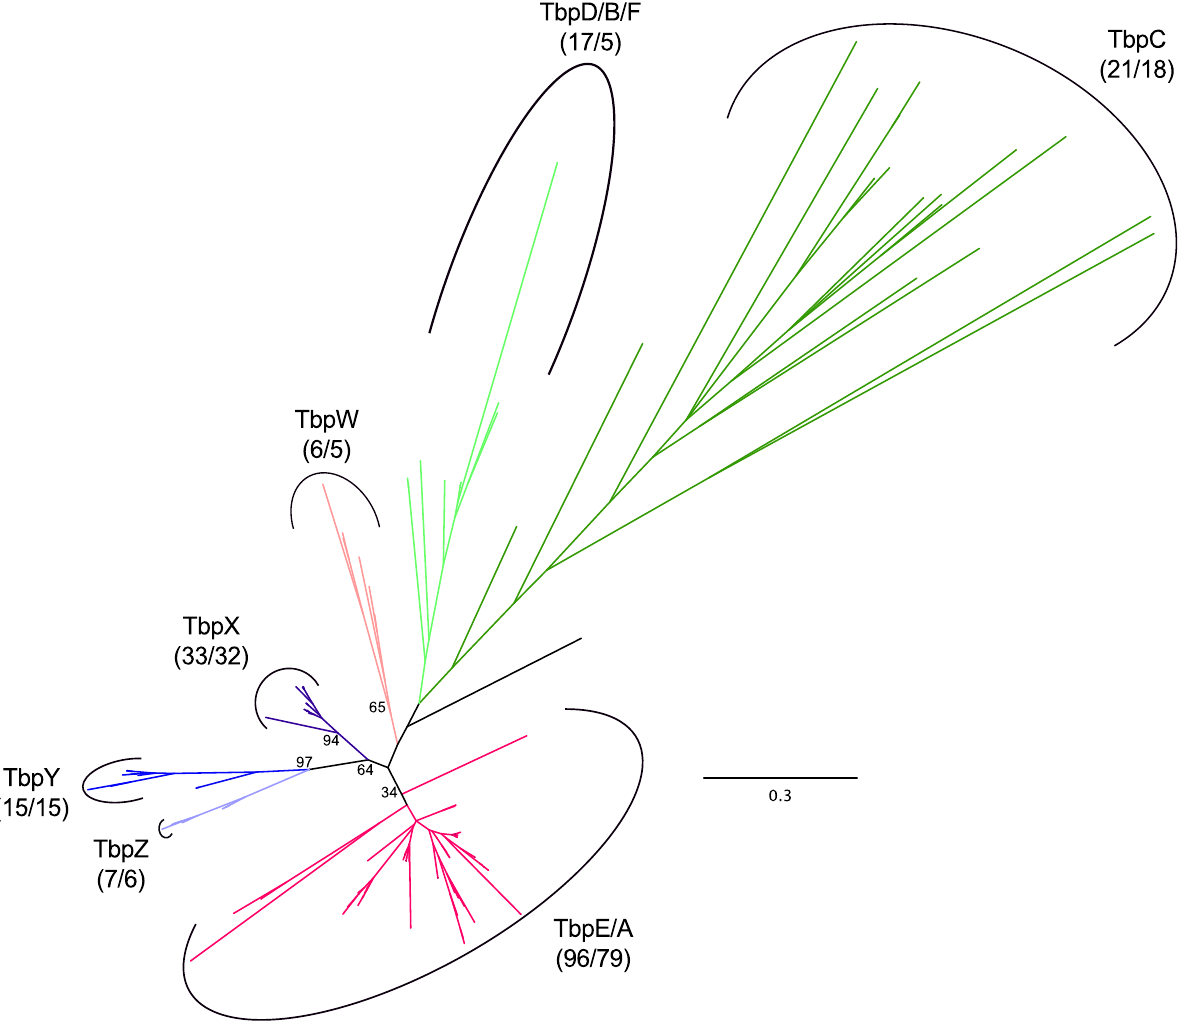
Figure 10. Haloarchaeal TATA-binding protein phylogeny. Unrooted phylogenetic tree of haloarchaeal TATA-binding protein (TBP) homologs. Dark green - TbpC, light green - TbpD/B/F, magenta - TbpE/A, salmon - TbpW, dark purple - TbpX, blue – TbpY, light purple – TbpZ, black - unassigned. Number of sequences and species represented in each clade is shown in parenthesis. Bootstrap support values over 30% are shown for major clades. See Dataset S7 for tree file.